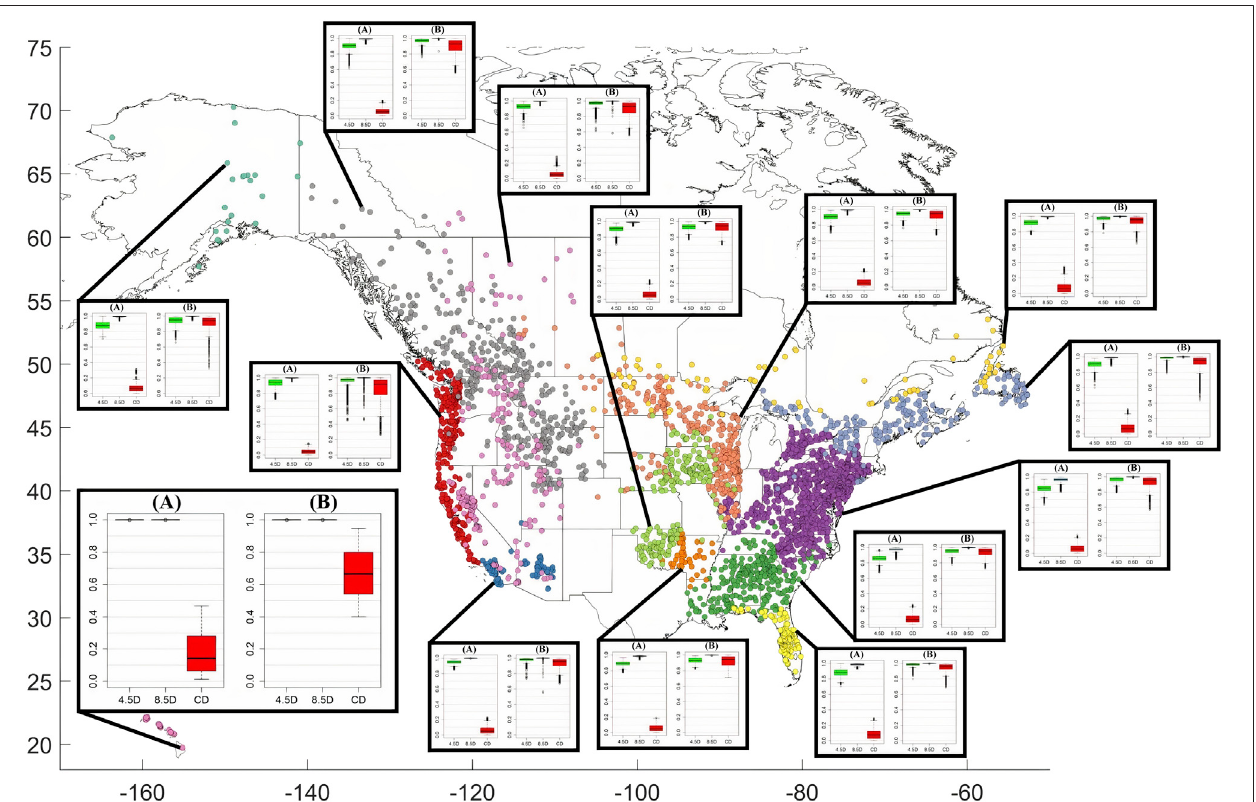
FIGURE 7 | Boxplots of water-demand components of the risk score for each subregion in winter and summer. (A) for each region includes: 4.5D (8.5D) — the probabilityofanincreaseinwaterdemandinwintergiventheRCP4.5(RCP8.5)emissionscenario,andCD — thepresent(1993 – 2012)freshwaterdemand,normalizedto be between 0 and 1. (B) shows the same components (4.5D, 8.5D, and CD) but calculated for summer. The thick black lines of the boxplots indicate the median value while the box shows the range between the fi rst and third quantiles. The points outside the range of the whiskers can be considered as outliers. Names of subregions are given in Figure 5